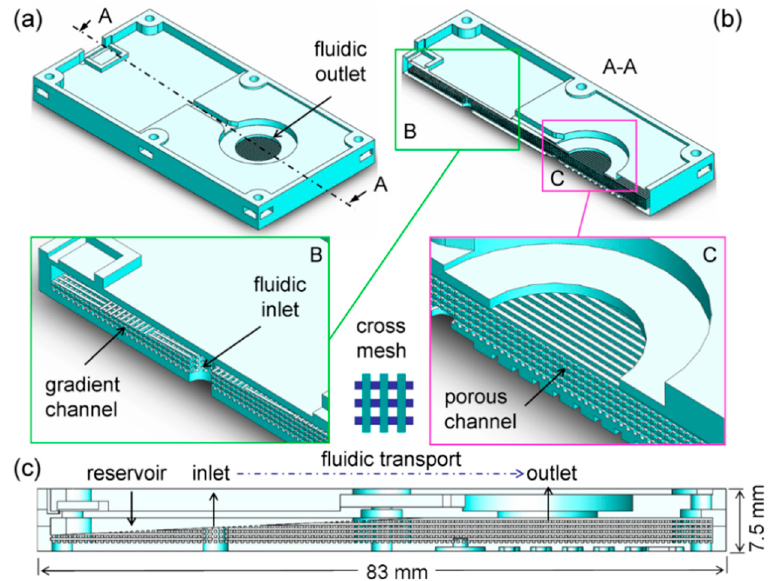
Figure 1. Design of microfluidic channels and grid structures in the study: ( a ) The three-dimensional structure of main body featuring a fluidic outlet of droplets; ( b ) The cross-section A–A of the structure with cross meshes inside highlighting the gradient channel nearby a fluidic inlet (see inset B) and the channel in the neighborhood of the fluidic outlet (see inset C); ( c ) The reservoir ready for fluidic transport through the channel.